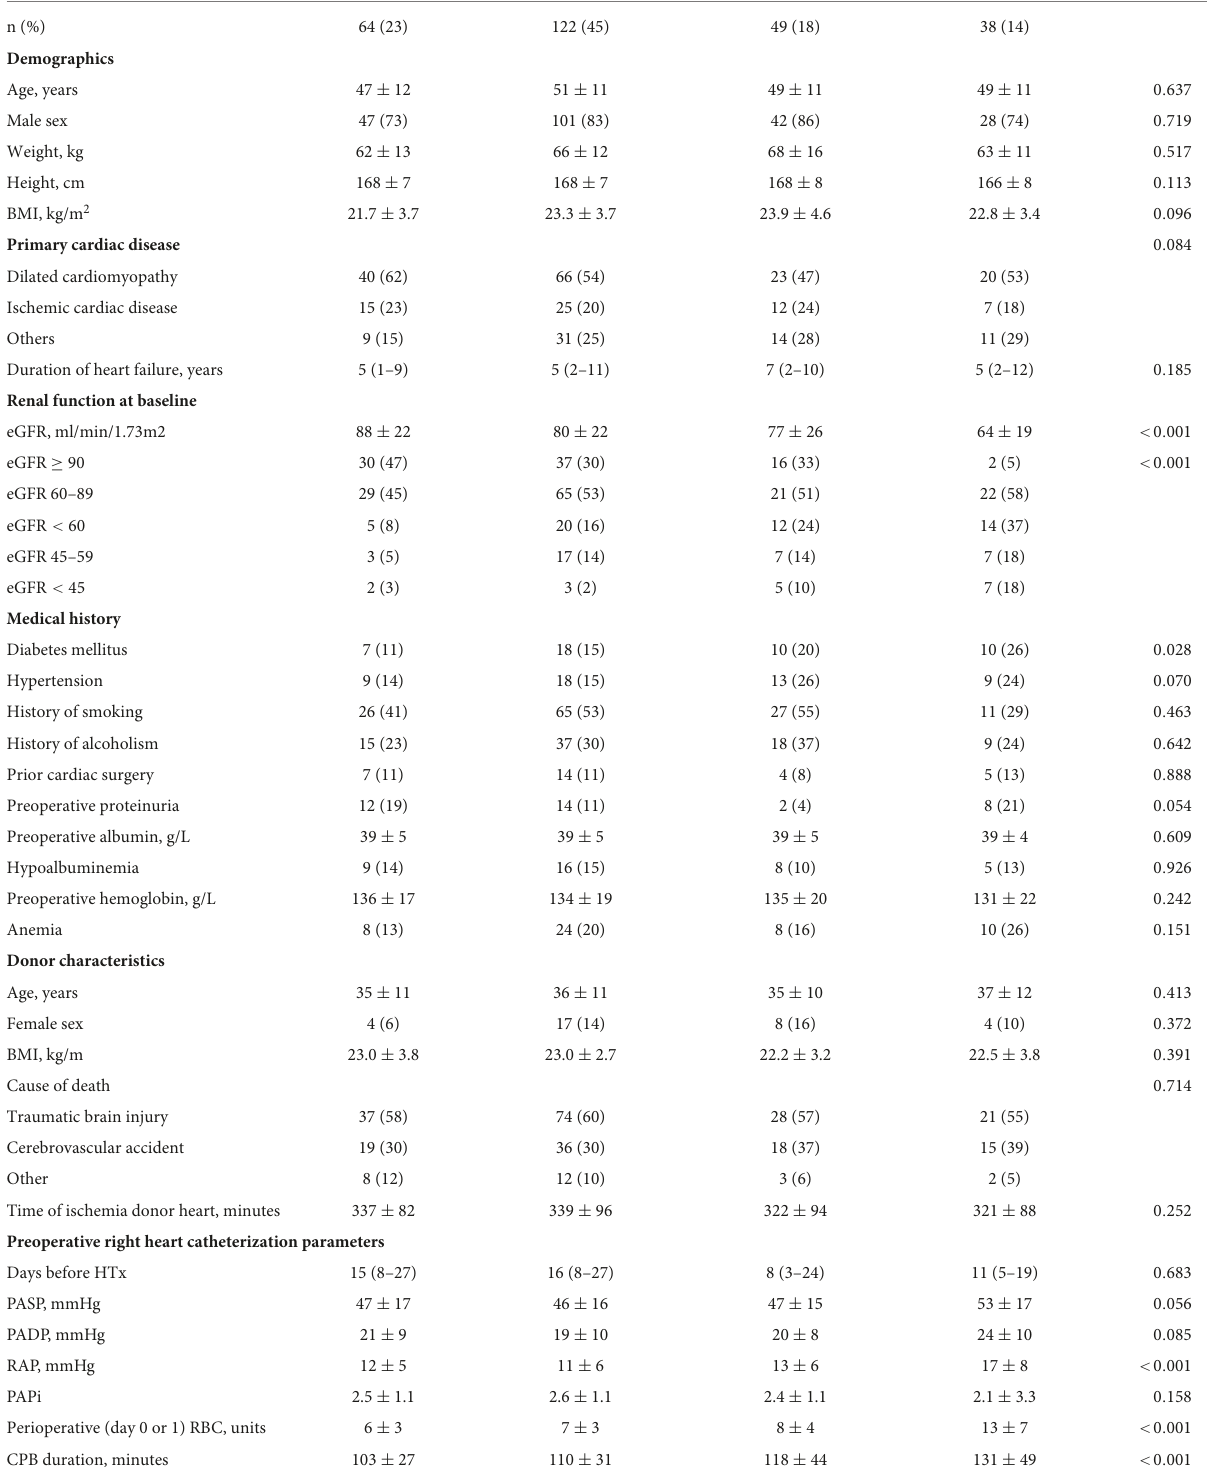
TABLE 1 Baseline characteristics and perioperative data according to the postoperative AKI